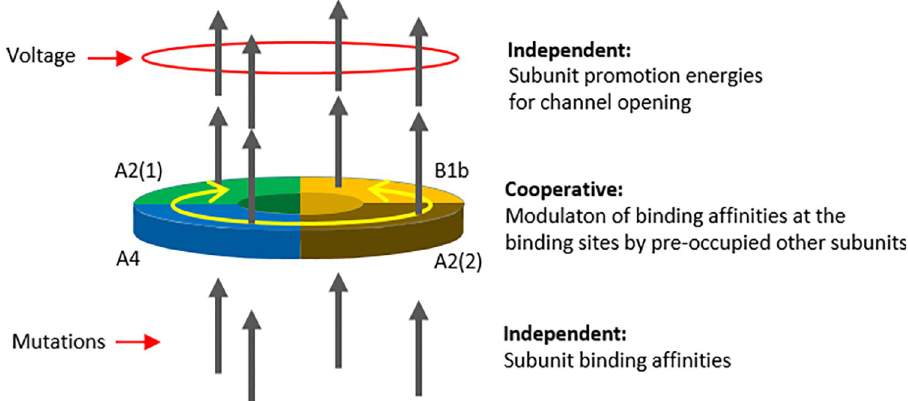
Fig 7. Schematic summarizing the nature of the processes following ligand binding. Pre-occupied subunits modulate the binding affinity of the other binding sites, presumably at the level of the CNBD, generating pronounced cooperativity. In contrast, both ligand binding itself and the subunit promotion energies for channel opening, DD G determined herein are independent